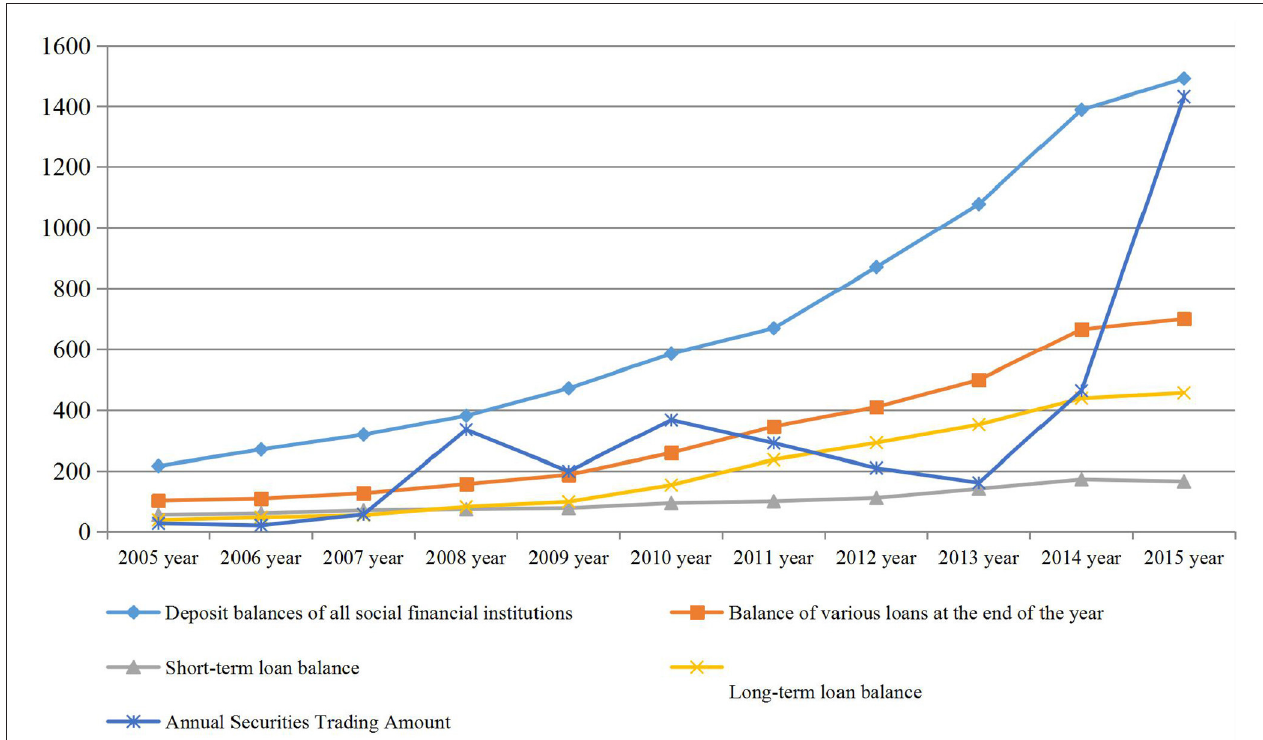
FIGURE 3 | Financial situation in recent years (Unit: 100 million yuan).